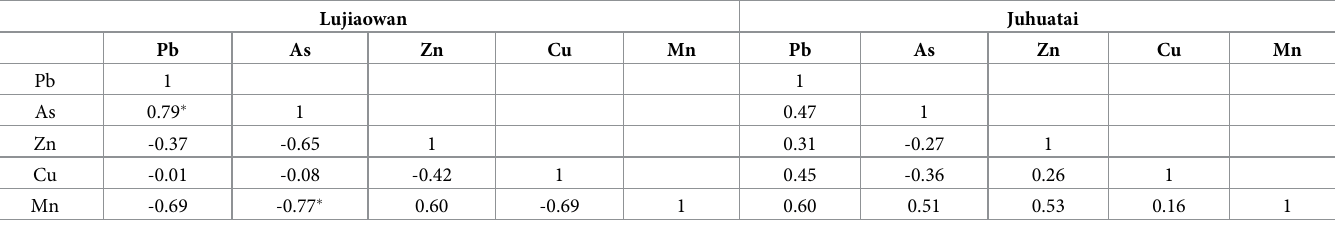
Table 7. Correlation analysis of soil heavy